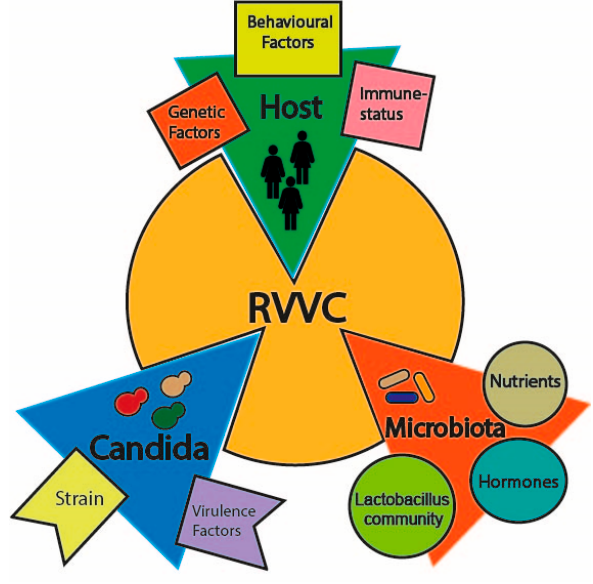
Figure 1. The factors contributing to recurrent vulvovaginal candidiasis (RVVC) onset. Table 1. Summary of the microbiological factors that act in quorum sensing of vaginal microbiota with potential stimulatory or inhibitory effects on Candida growth/ morphological switch. Factors